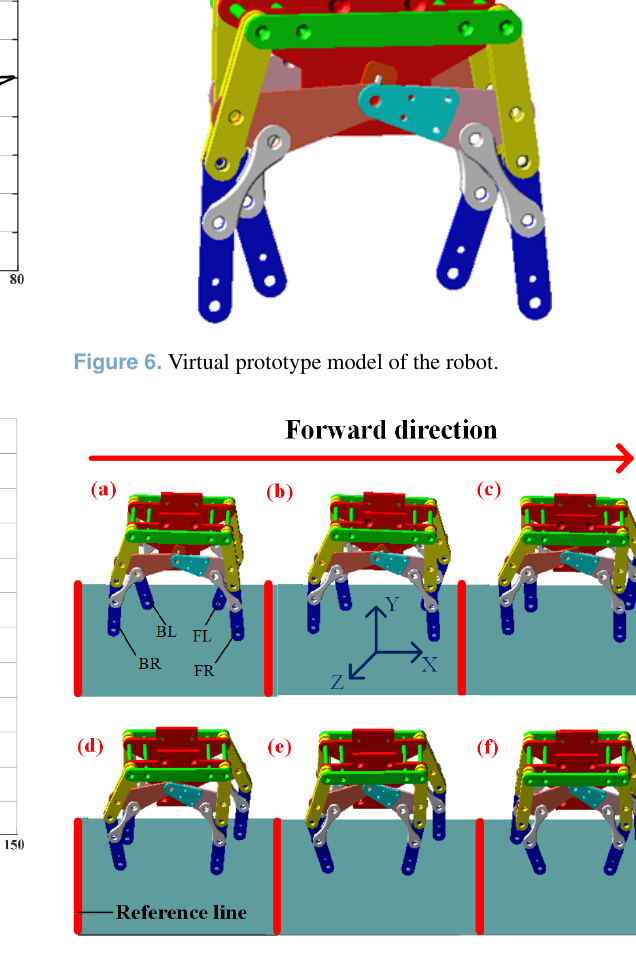
Figure 7. Forward sequence diagram of the